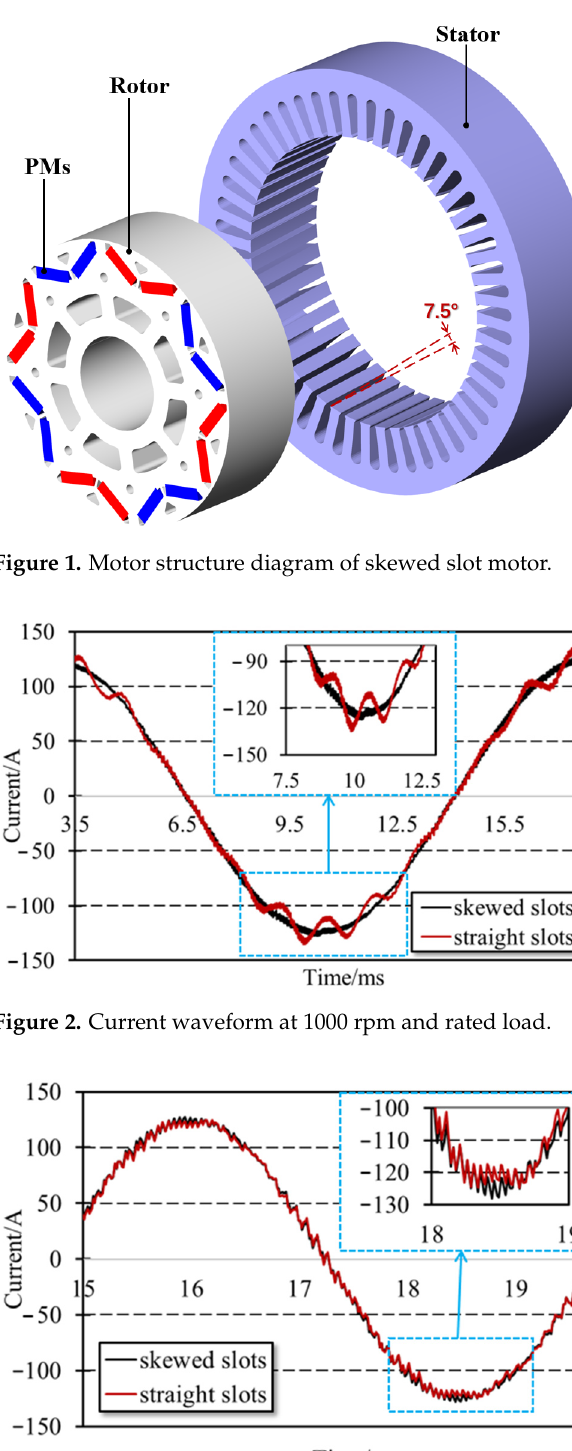
Figure 2. Current waveform at 1000 rpm and rated load .